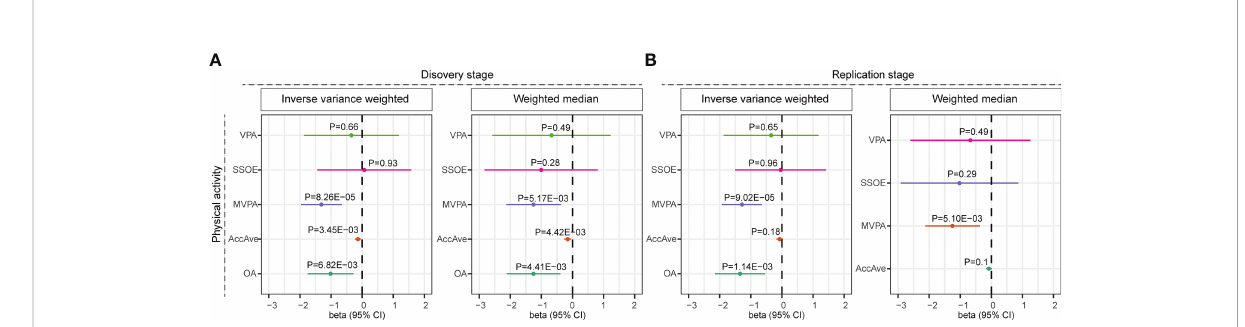
FIGURE 2 Forest plot showing results from the Mendelian randomization analysis. Mendelian randomization results were estimated using the inverse variance weighted and weighted median methods in the (A) discovery and (B) replication stages. Estimates are per 1 standard deviation increase in the trait. AccAve, overall acceleration average; MVPA, self-reported moderate-to-vigorous physical activity; VPA, self-reported vigorous physical activity; SSOE, strenuous sports or other exercises; OA, overall